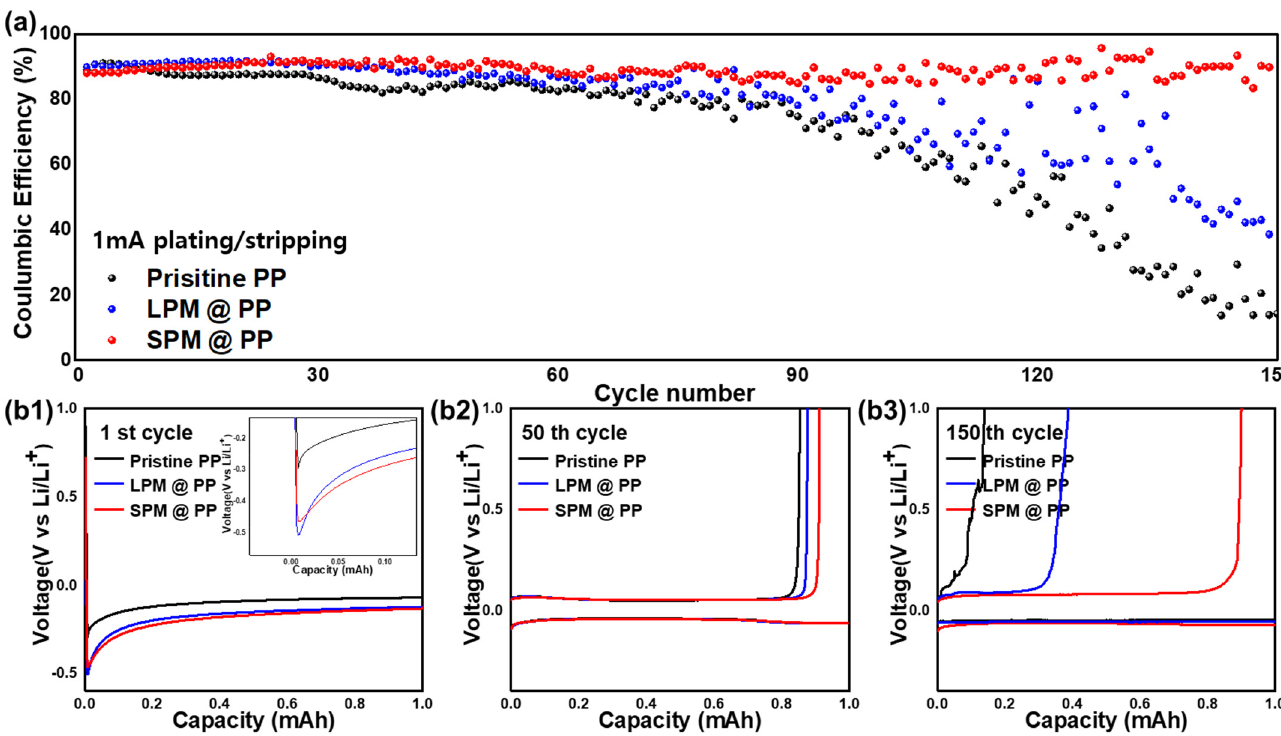
Figure 4. Electrochemical performances of Li-Cu cells with the pristine PP separator, and the LPM- and SPM-coated separators. ( a ) Coulombic efficiency at a current density of 1 mA cm − 1 and ( b1 – b3 ) voltage profiles at the 1st, 50th, and 150th cycles.